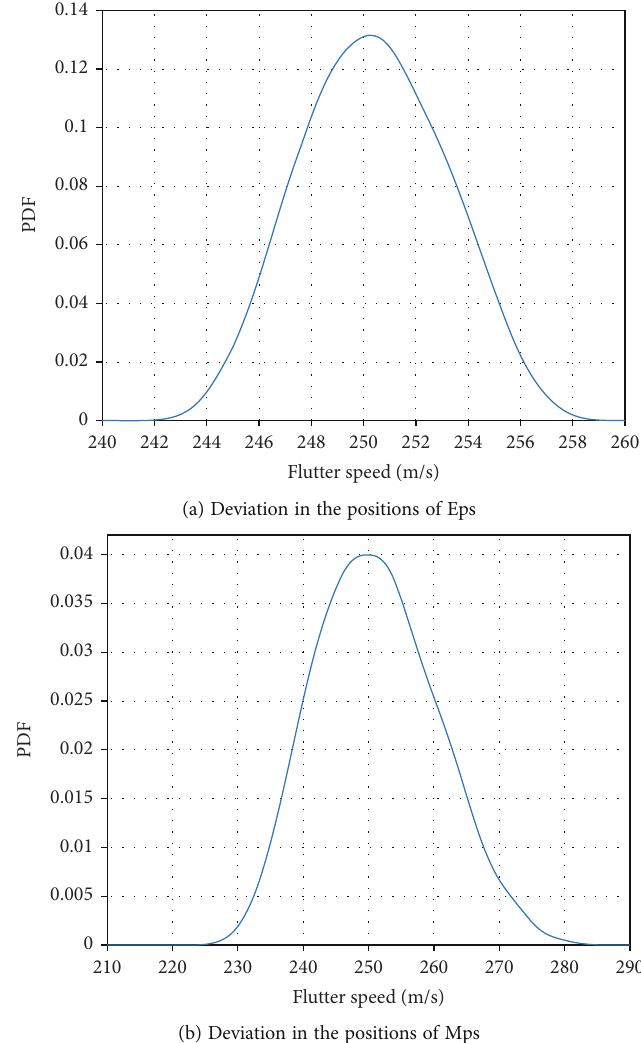
Figure 20: PDFs of fl utter speed: deviations in the positions of EPs and MPs